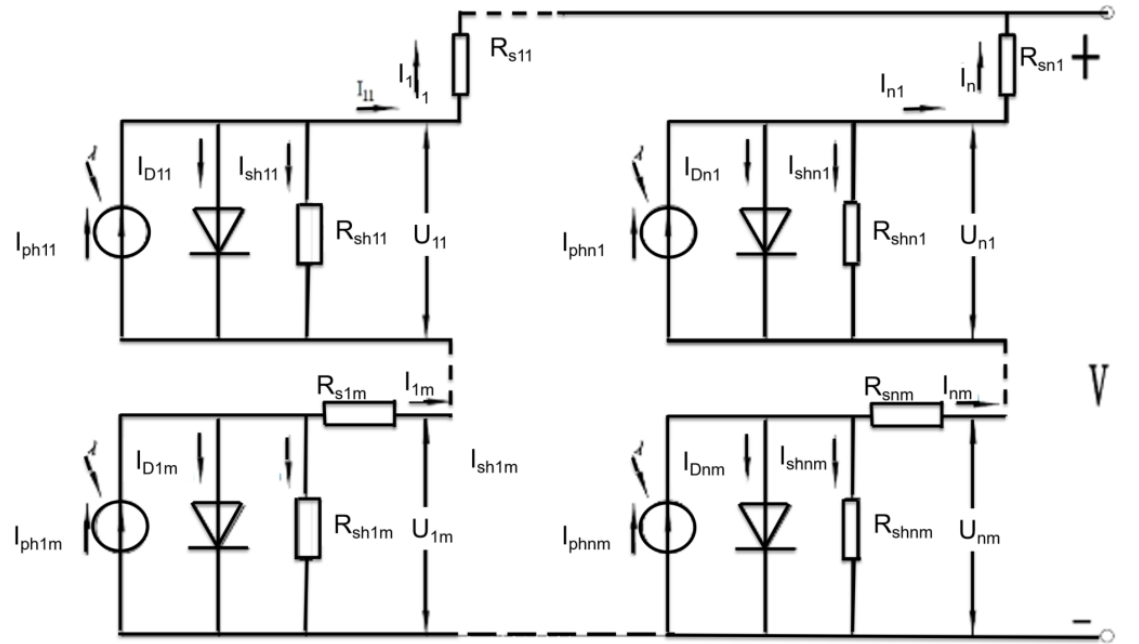
Figure 2. Equivalent circuit of the m series and n parallel connections in the photoelectric panels. The current output of photoelectric panel I can be computed as: I = n × I ph − n × I 0 × [ exp ( whereas the saturation current of photoelectric panel I 0 changes along with the cell temper- ature. The relationship between these factors can be expressed as: